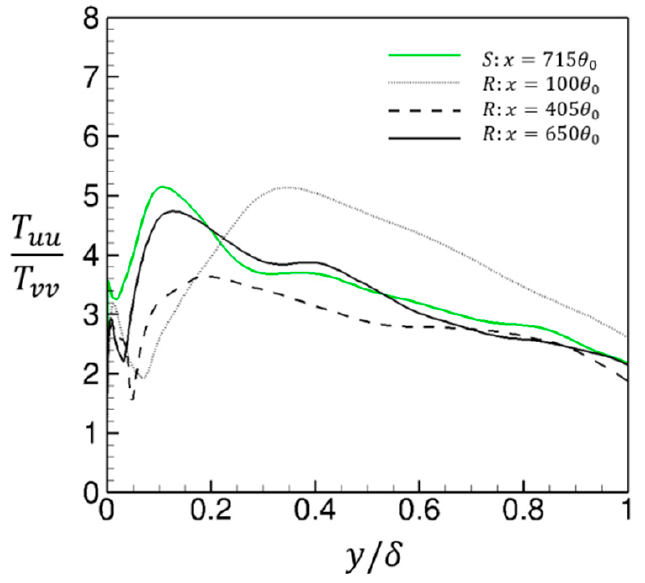
Figure 20. Wall-normal variation of the integral timescale ratio T uu / T vv at discrete streamwise stations for cases S and R .